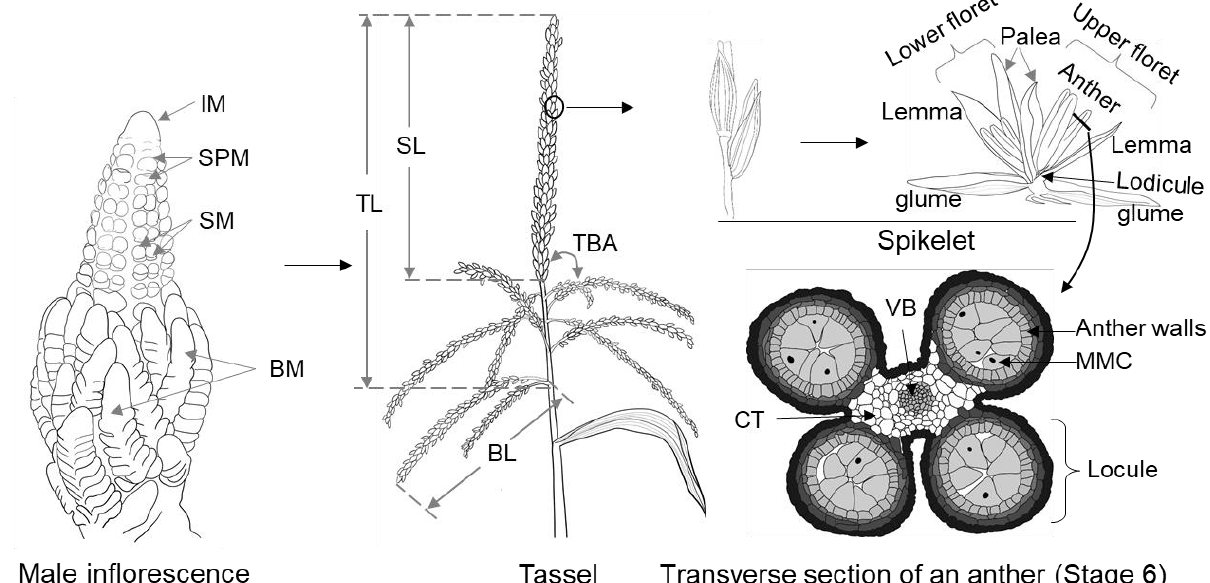
Figure 1. Schematic diagram of the developmental process of male inflorescence. BL: branch length; BM: branch meristem; CT: connective tissue; IM: inflorescence meristem; MMC: microspore mother cell; SL: central spike length; SM: spikelet meristem; SPM: spikelet-pair meristems; TBA: tassel branch angle; TL: tassel length; VB: vascular bundle.